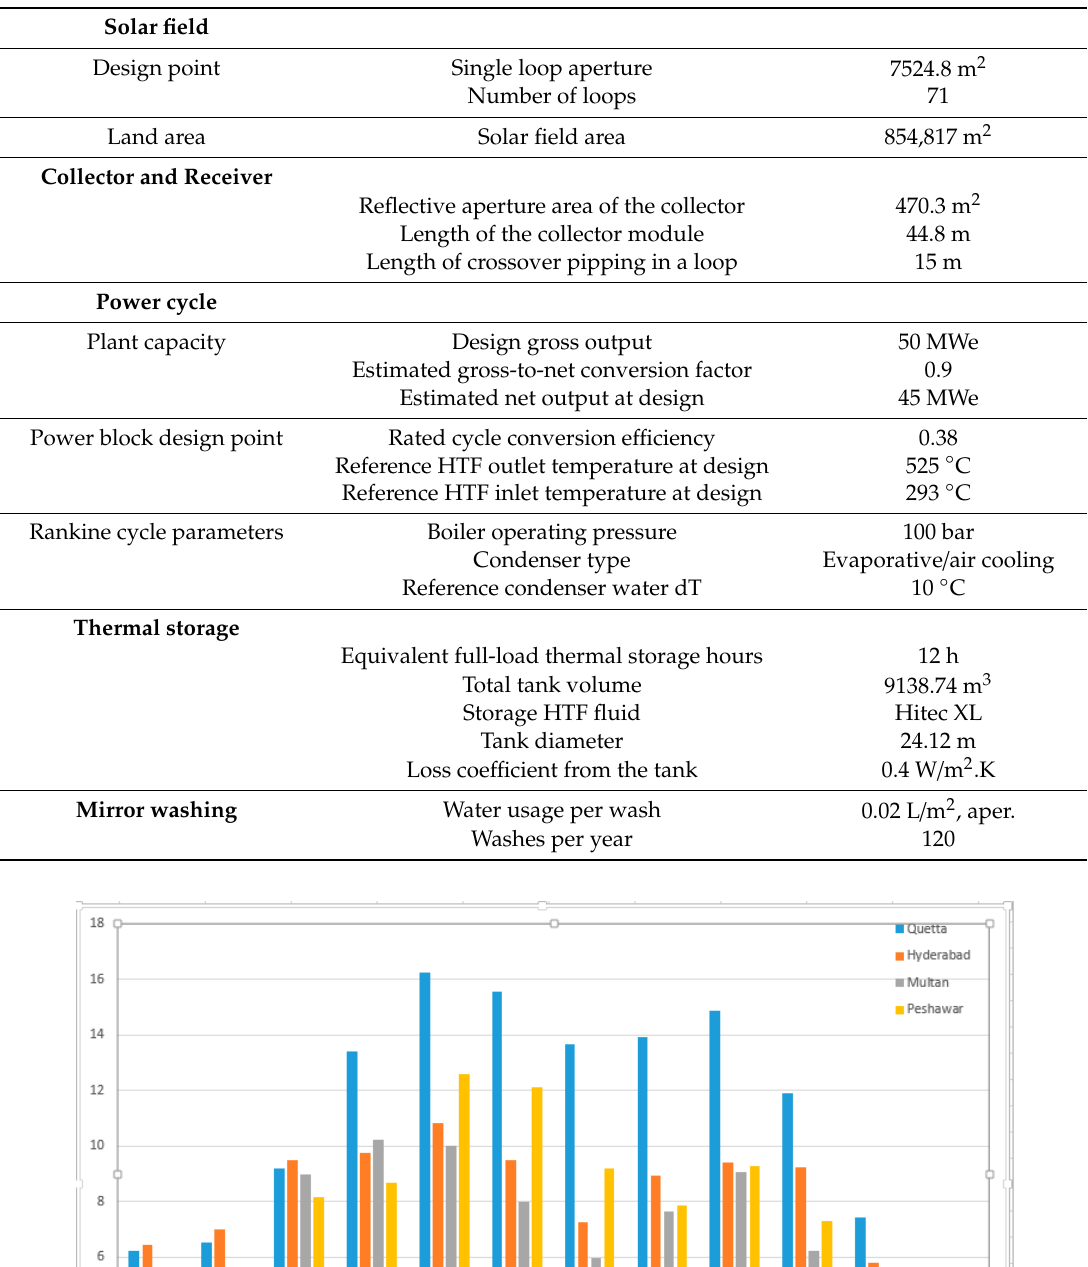
Table 10. Design characteristics and specifications of the 50 MWe LFR plant.